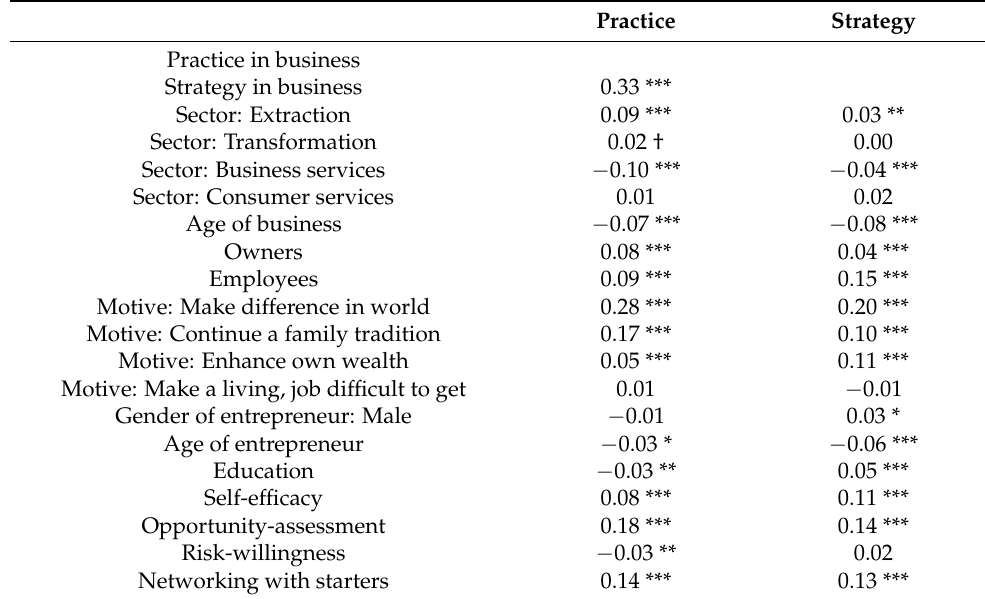
Table 2. Correlations among individual-level variables of interest (N = 8278 businesses in MENA and